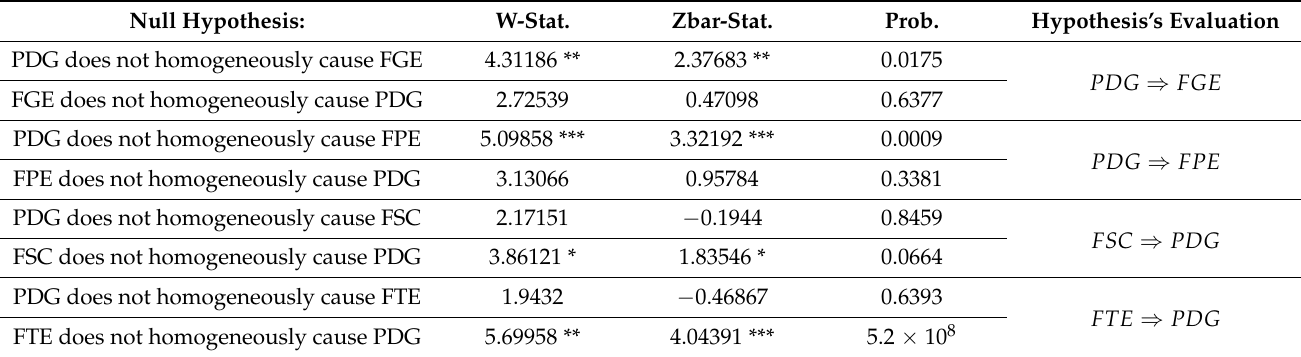
Table 6. Dumitrescu-Hurlin Panel Causality Test